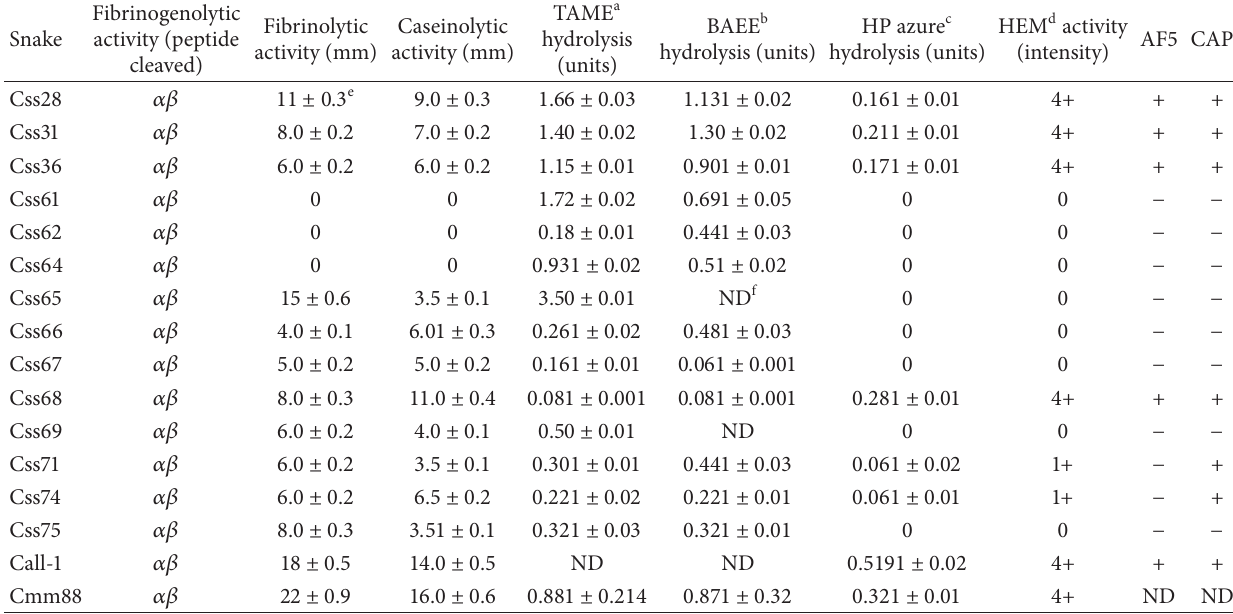
Table 3: Antibody recognition: proteinase and hemorrhagic activities of the C. s. scutulatus venoms. Fibrinogenolytic Snake activity (peptide